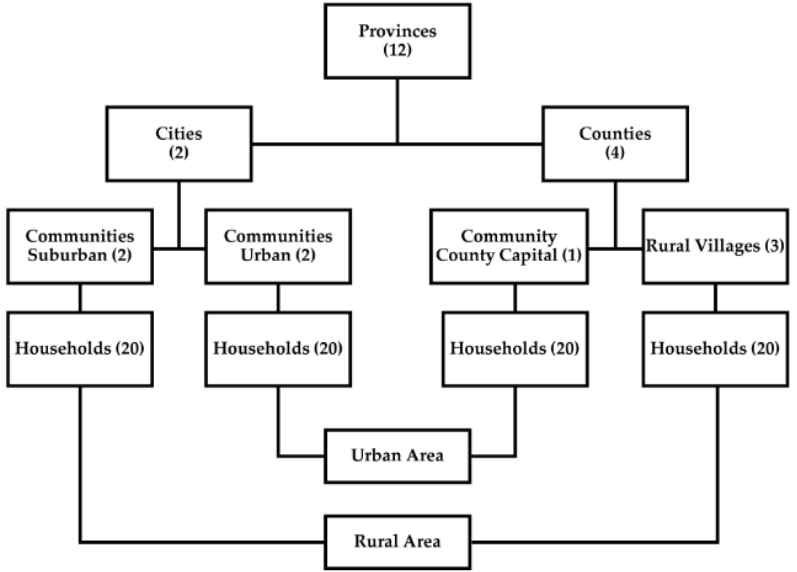
Figure 1. The sampling scheme used in the China Health and Nutrition Survey.